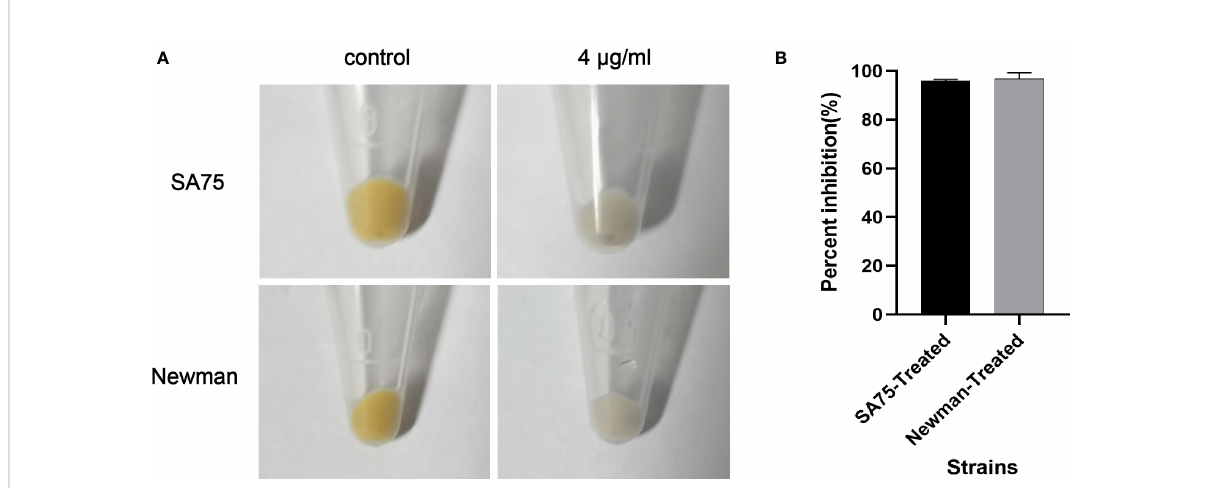
FIGURE 3 Effect of SYG-180-2-2 on wild-type S. aureus SA75 and Newman pigmentation. (A) The images show the spun-down cells. (B) Inhibition rate of pigment